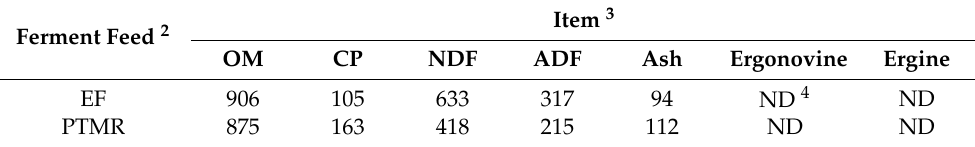
Table 1. Nutrient composition of the ferment feed during the experiment (g/kg of DM 1 ). Ferment Feed 2